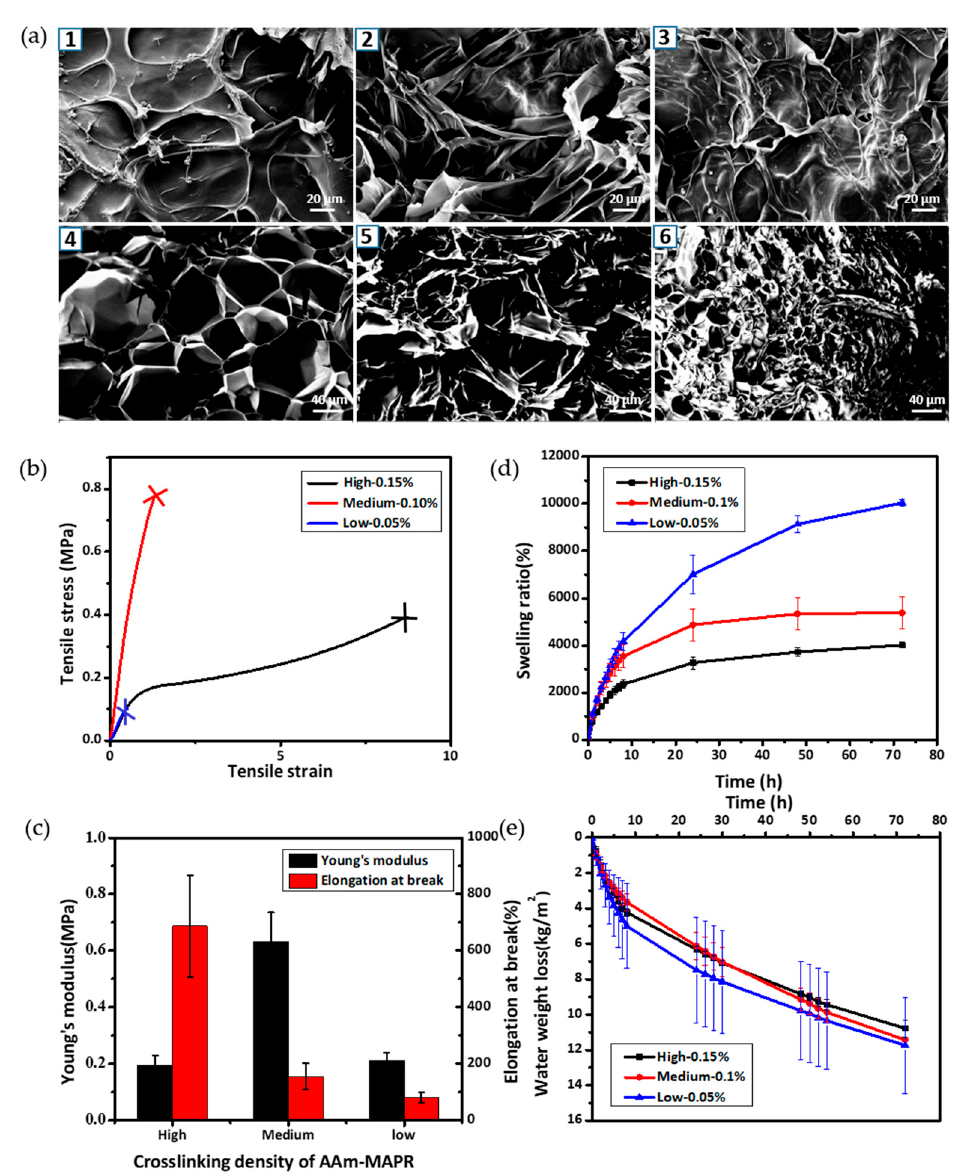
Figure 3. Physical evaluation of hydrogel patches at different MBAA concentrations. ( a ) SEM images of hydrogel patch with three crosslinking densities from the surface (1–3) and the cross-section views (4–6): 1 and 4: high crosslinking density (0.15% MBAA concentration); 2 and 5: medium crosslinking density (0.1% MBAA concentration); and 3 and 6: low crosslinking density (0.05% MBAA concentration); ( b ) tensile stress-strain curves; ( c ) Young’s modulus and elongation at break; ( d ) swelling ratio; and ( e ) water vapour transmission rate of hydrogel patches with the three MBAA crosslinking densities.